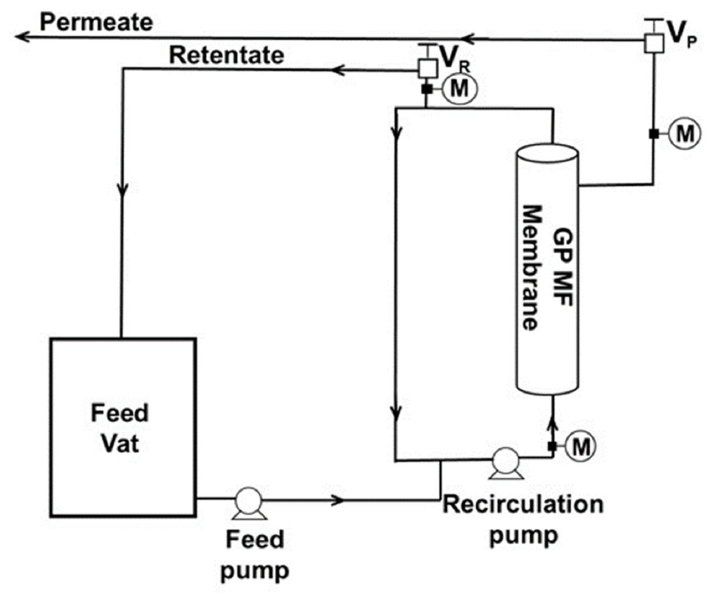
Figure 1. Simplified diagram of the MF system used in the study: M—manometer, V R —retentate outlet valve, V P —permeate outlet valve.